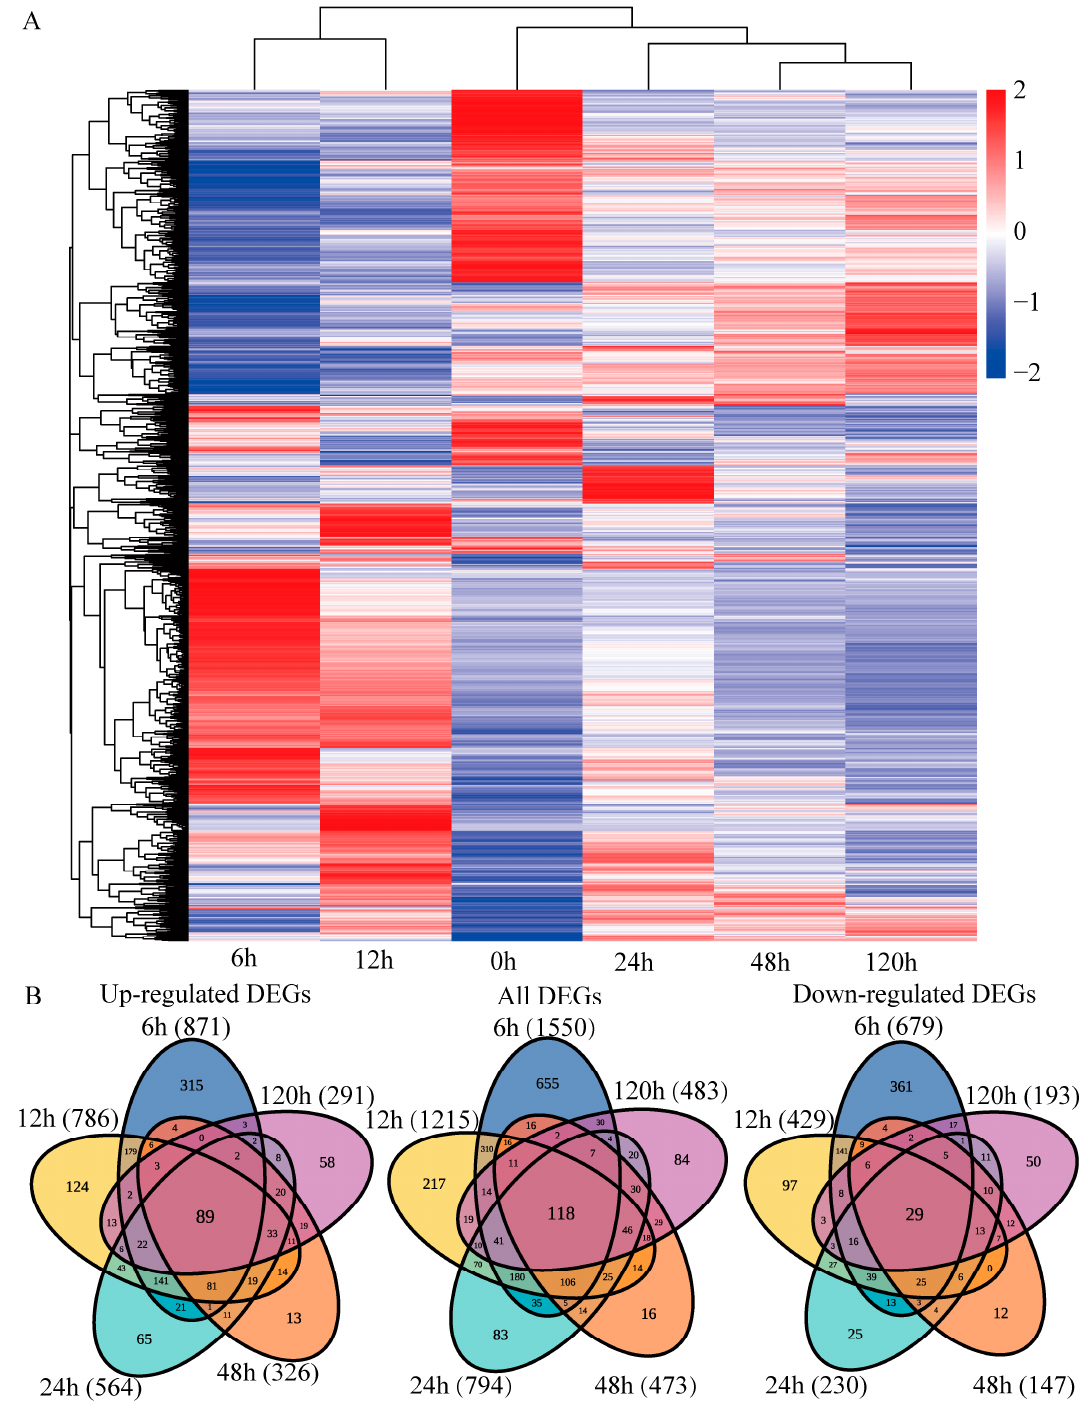
Figure 3. Overview of the differentially expressed genes (DEGs). ( A ) Clustering analysis and ( B ) Venn diagrams of DEGs.